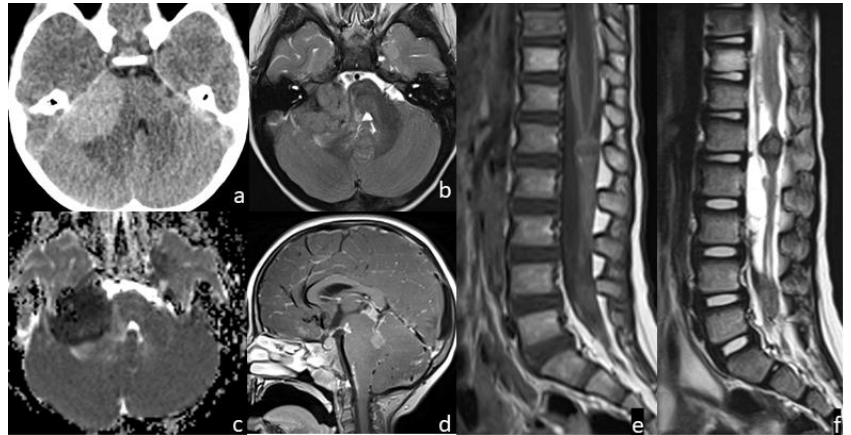
Figure 2. Patient #2 imaging features. Axial non contrast brain computed tomography (CT) ( a ) showed a bulky central nervous system (CNS) hyperdense lesion within the right cerebellopontine angle, with inhomogeneous signal in axial T2w image ( b ), but with restricted diffusion in diffusion weighted imaging (DWI) ( c ). Post-contrast sagittal T1w image of the brain ( d ) and post-contrast sagittal T1w ( e ) and T2w ( f ) images of the spine showed numerous other brain and spine leptomeningeal lesions. MRI of the spine demonstrated thickened leptomeninges with multiple extra medullary enhancing nodular lesions ( e ); the nodular enhancing foci within the conus and along the nerve roots of the cauda equine ( f ) had an inhomogeneous low signal intensity on sagittal T2w images indicating a hemorrhagic component within them.